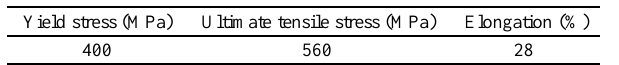
Table 2 Mechanical properties of the High Strength Low Alloy (HSLA) Steel